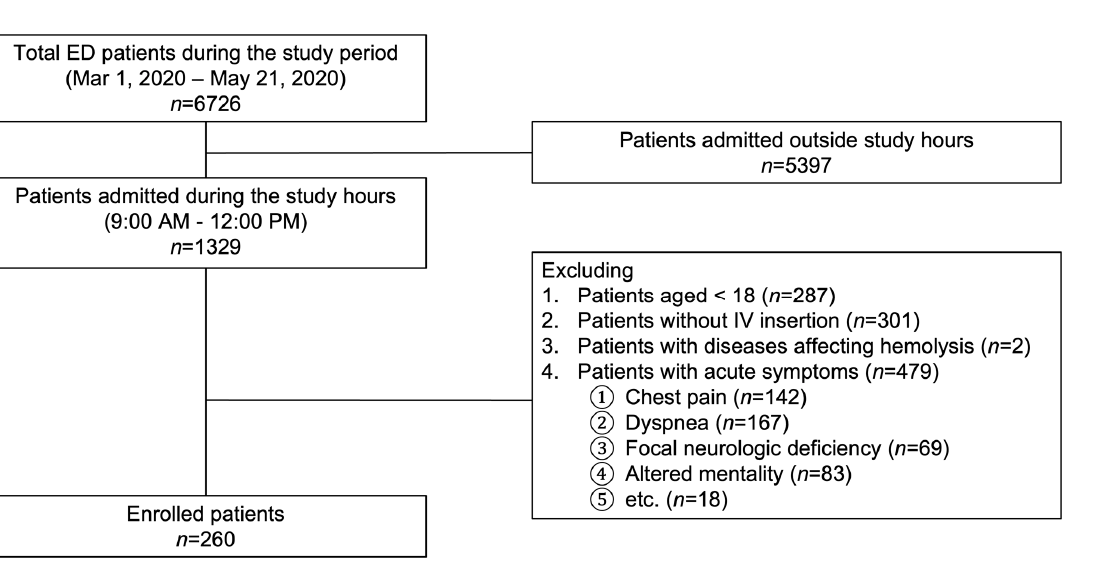
Figure 3. Flowchart of the study. ED, emergency department; IV, intravenous.